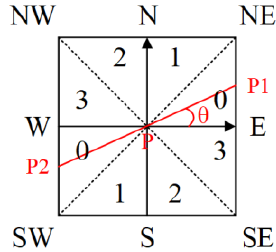
Figure 11. The map of the gradient and directions.